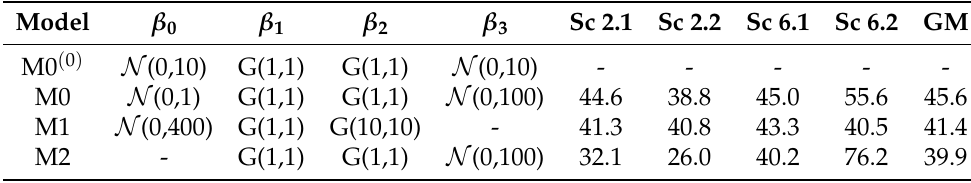
Table 2. Calibrated prior parameters for each model and the corresponding PCS under 4 calibration scenarios. GM is the geometric mean of the PCS across the four scenarios. Results are based on 500